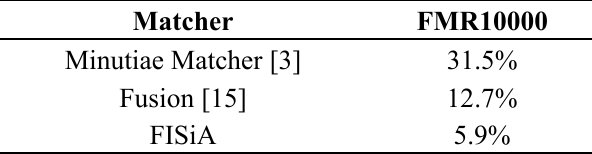
Table 2. Comparison between the minutiae matcher and FISiA on